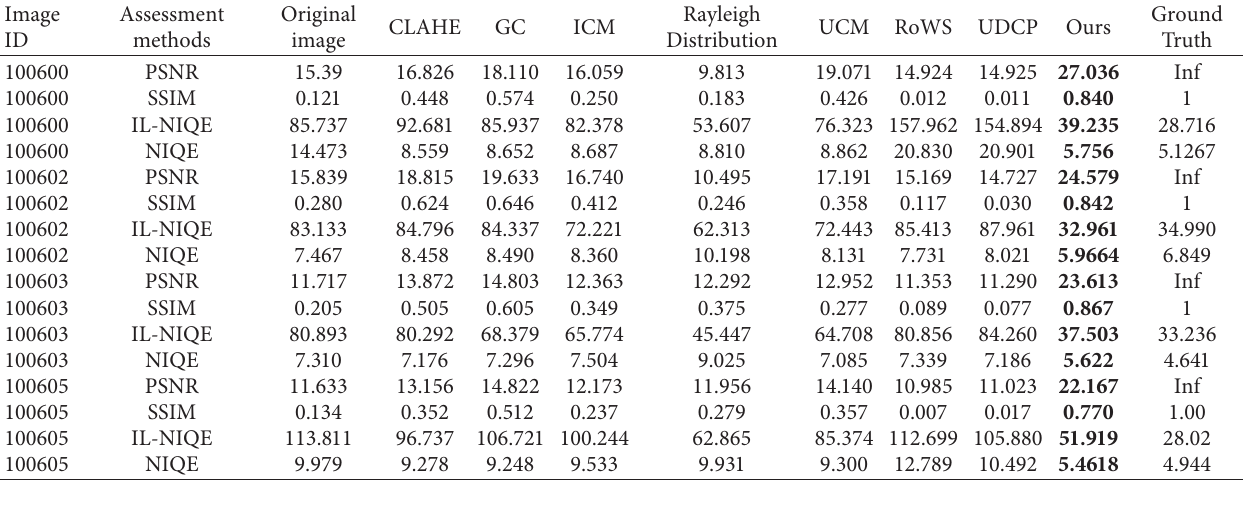
Table 2: The test results of objective IQA methods between our algorithm and underwater enhancement and restoration algorithms.